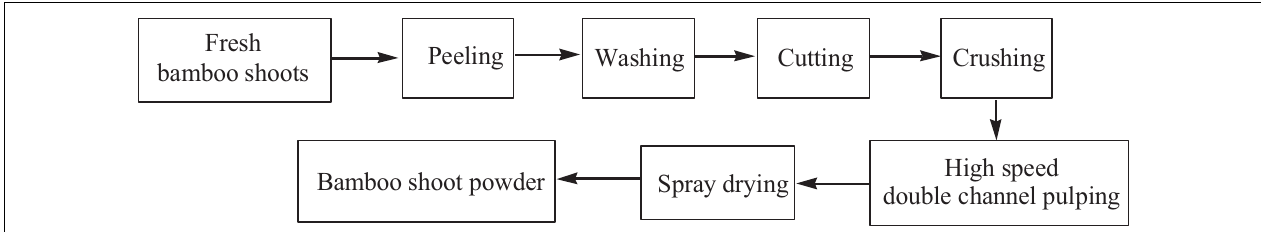
FIGURE 1 | Preparation process of shoot powder from fresh Lei bamboo shoots.